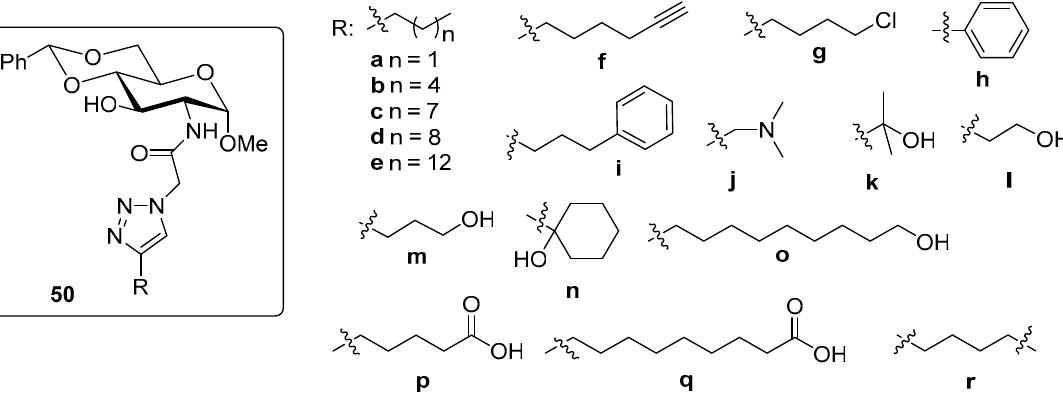
Figure 35. Other gelators with a triazole backbone [40], n stands for the number of repeating CH 2 .